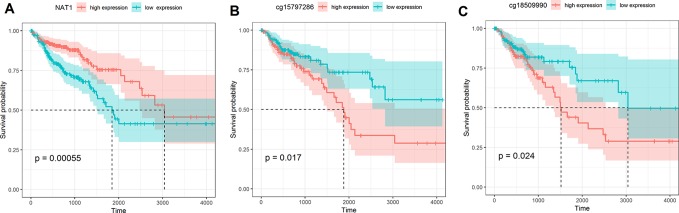
(A) Kaplan–Meier curve of N-acetyltransferase 1 (NAT1) mRNA expression in COAD; (B) Kaplan–Meier curve of cg15797286 in COAD; (C) Kaplan–Meier curve of cg18509990 in COAD.